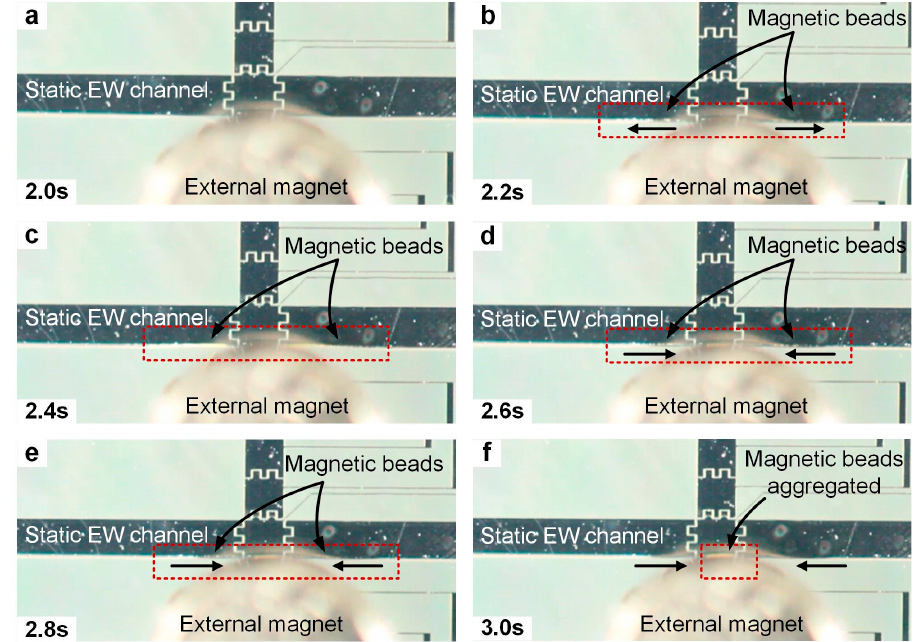
Figure 3. The merging of a droplet of magnetic beads into a static electrowetting channel. ( a ) A static electrowetting channel was formed. A magnet was placed on the top of the device over a droplet of magnetic beads (not shown). ( b , c ) The droplet of magnetic beads was merged into the channel, and the beads migrated for ~1 mm both upstream and downstream. ( d , e ) The beads were attracted by the magnet and migrated in the reverse directions. ( f ) The beads were aggregated on the electrode under the edge of the magnet.